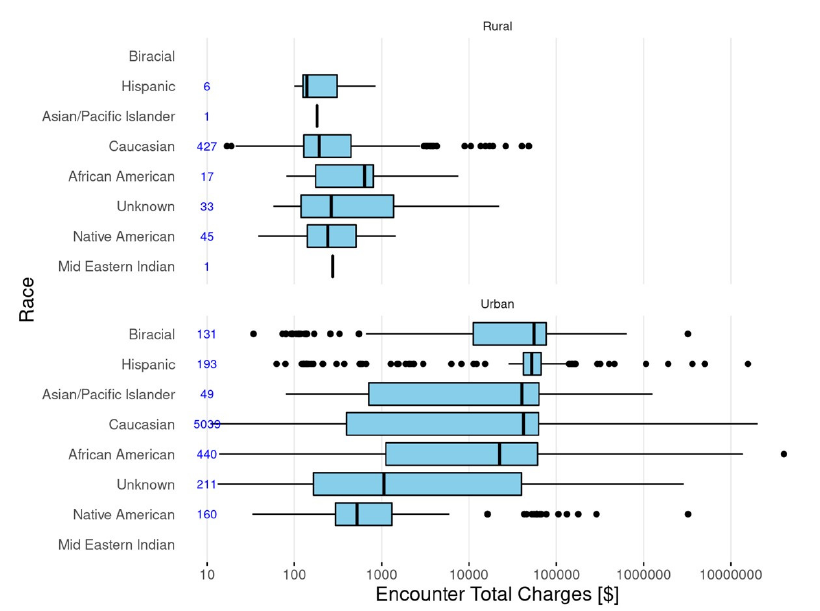
Figure 4. Distribution of total patient charges across races/ethnicity for patients in rural and urban healthcare settings.